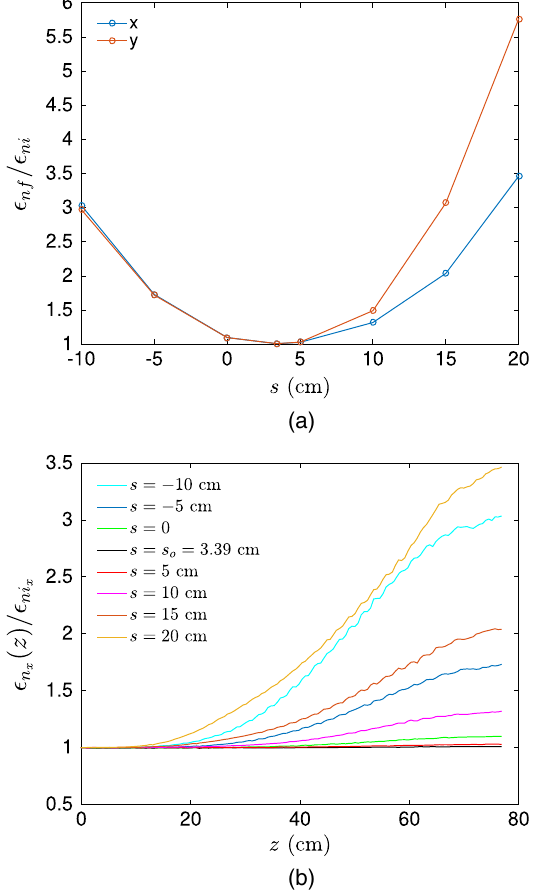
FIG. 6. The normalized emittance growth of the witness beam for different s . (a) The ratio of final emittance (at the plasma exit) to the initial emittance (at the plasma entrance) for different cases. (b) The evolution of ϵ n inside the plasma for different cases, x corresponding to the blue line in